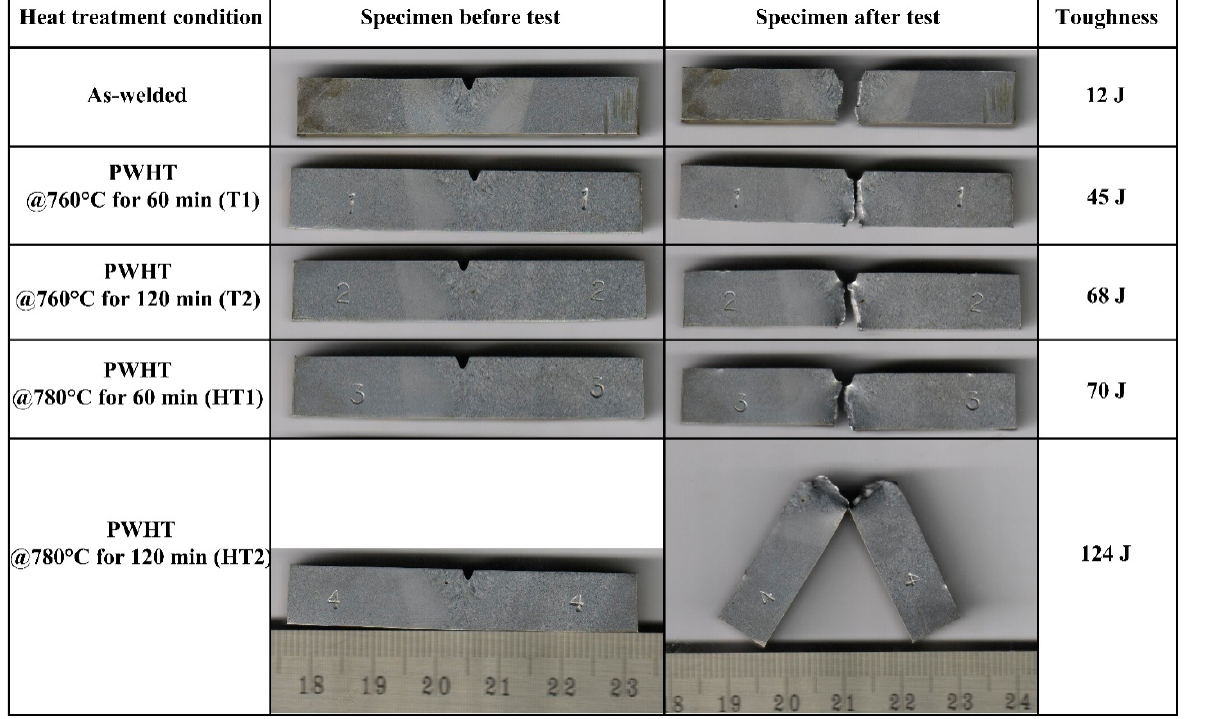
Figure 18. Impact test results for AW and heat-treated joints showing impact toughness values and impact specimens before and after fracturing.